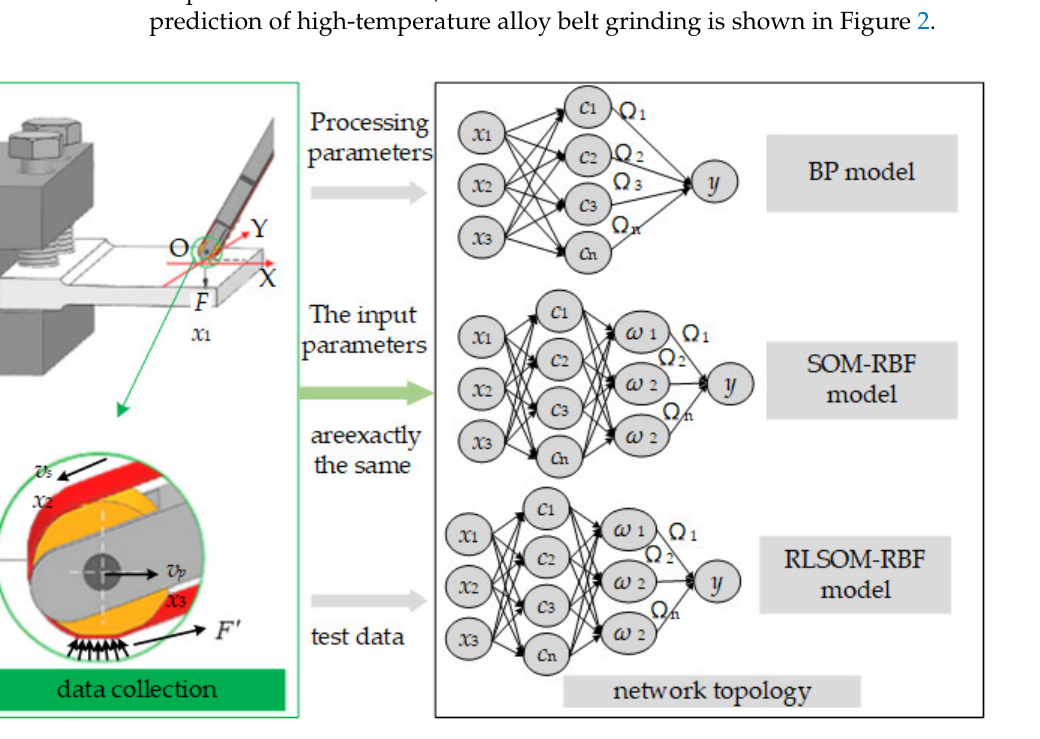
Figure 2. Neural network model for surface roughness prediction.